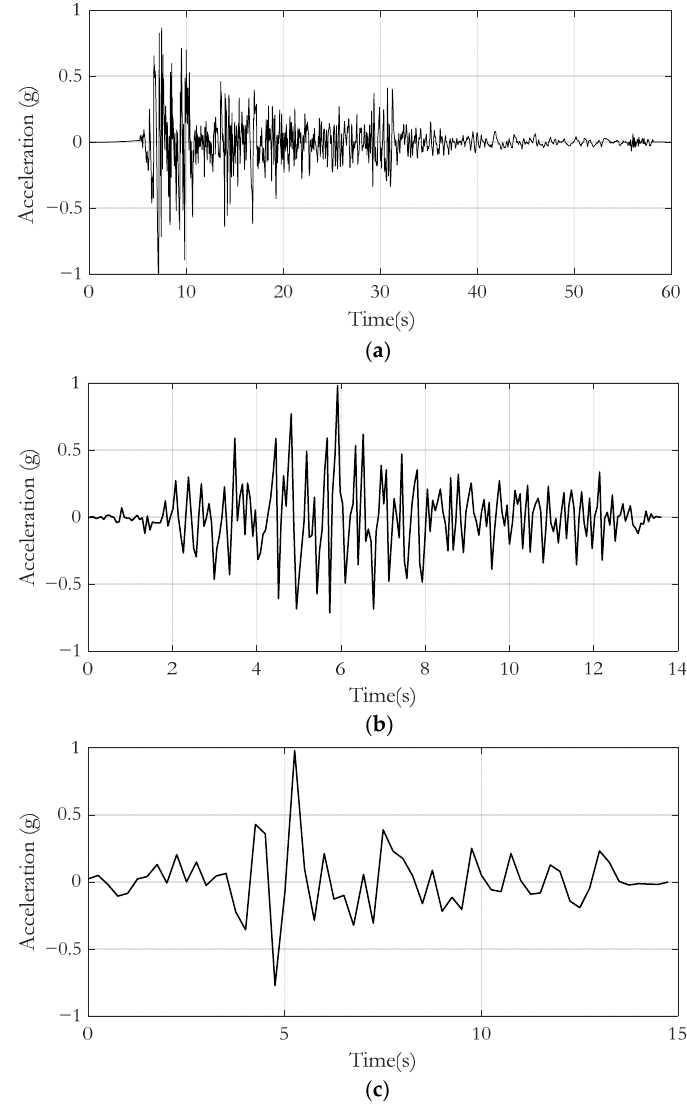
Figure 12. Earthquake motions: ( a ) El Centro(1940); ( b ) Ofunato(1978); ( c ) Hachinohe(1968).